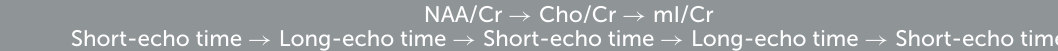
TABLE 2 Mean values of neurometabolite ratios in analyzed locations of the